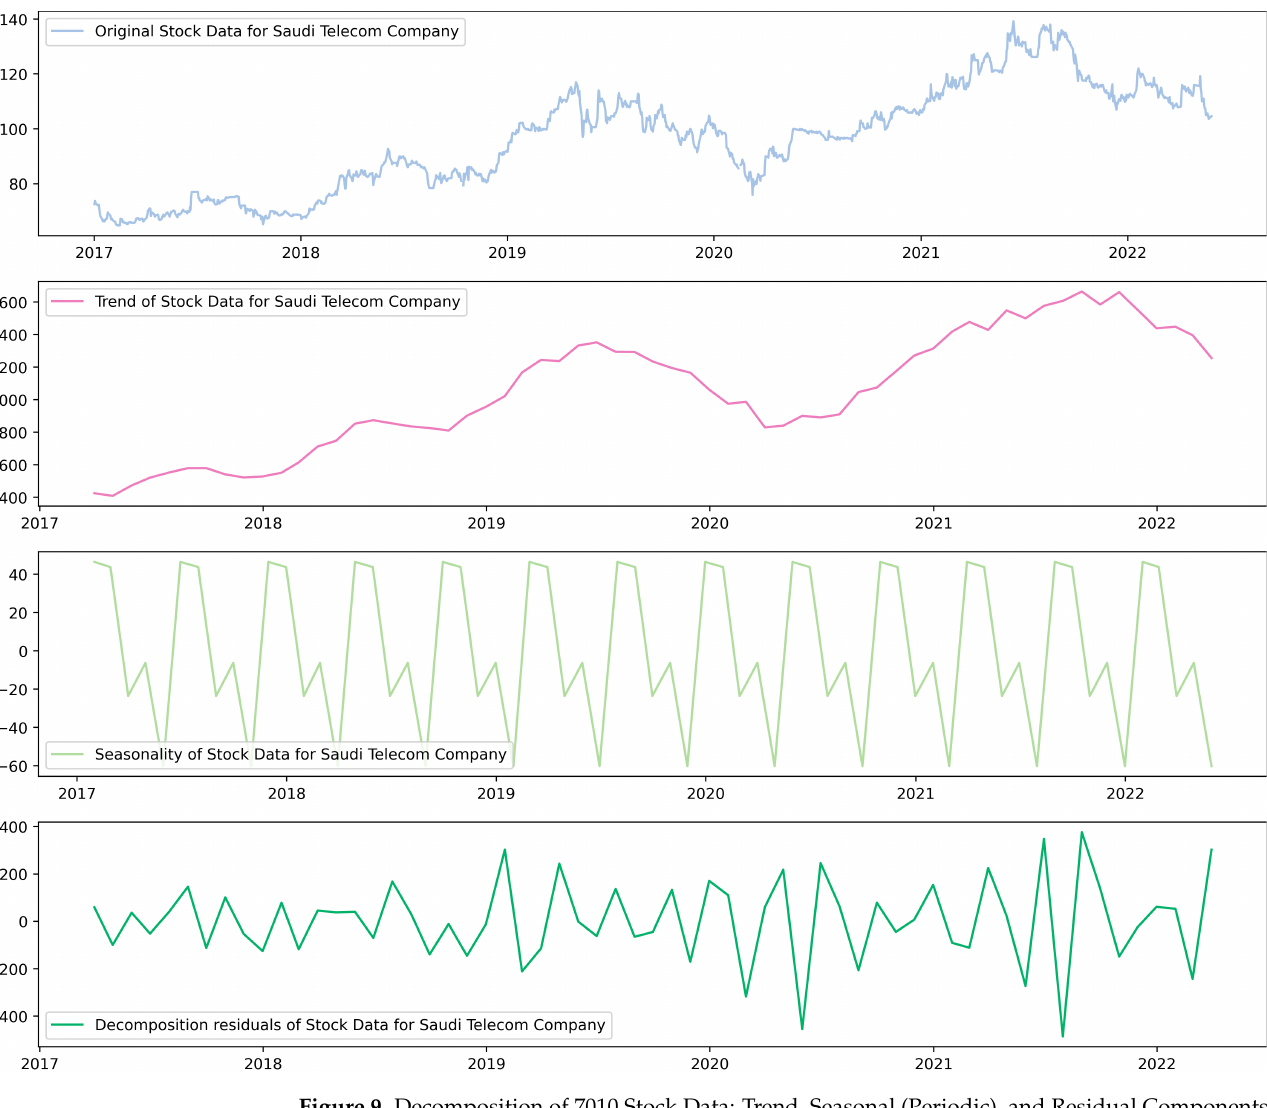
Figure 9. Decomposition of 7010 Stock Data: Trend, Seasonal (Periodic), and Residual Components. Table 2. Results of Augmented Dickey–Fuller (ADF) Unit Root